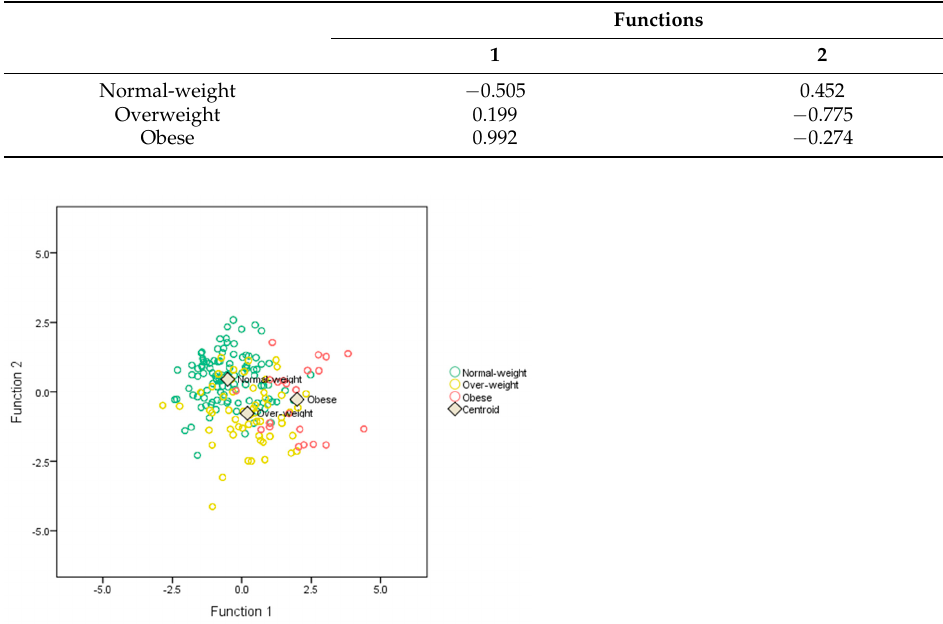
Figure 1. Graphical representation of each BMI-ranked group based on discriminant dimensions.